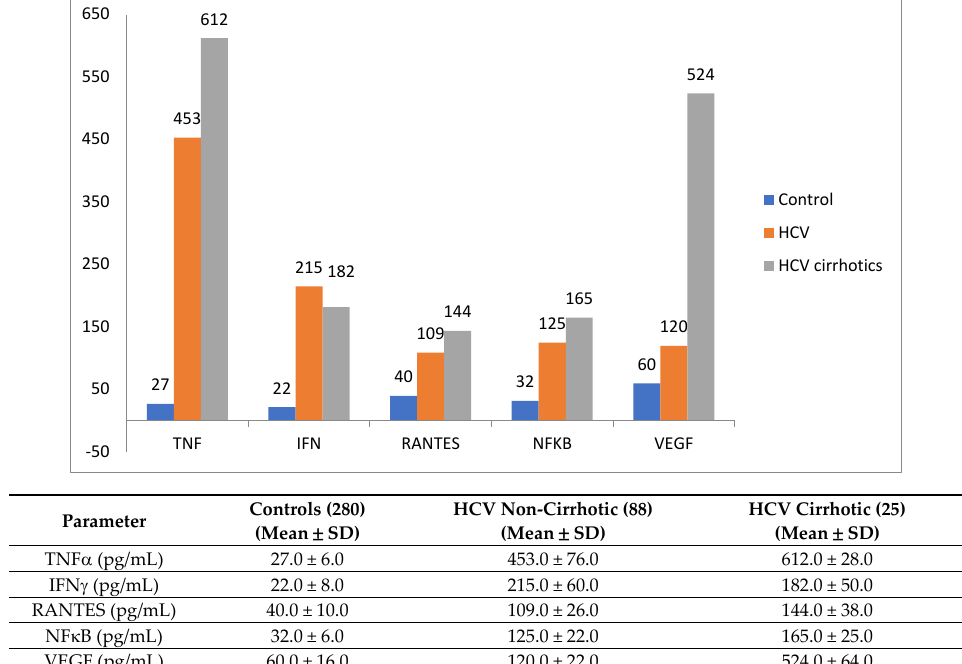
Figure 2. Serum levels of tumor necrosis factor alpha (TNF α ), interferon gamma (IFN- γ ), regulated upon activation normal T cell expressed and secreted (RANTES) nuclear factor kappa B (NF κ B), vas- cular endothelial growth factor (VEGF) in controls, and in HCV-infected patients. All the parameters are expressed as pg/mL; mL-milliliter; pg-picogram. The levels of TNF α are significantly different between the HCV non-cirrhotic and cirrhotic individuals ( p = 0.05) and VEGF ( p = 0.0010). The TEM micrographs present several apoptotic hepatocytes and apoptotic bodies (AB). The micrographs show large deposits of lipids in the cell. The micrograph reveals an enlarged smooth endoplasmic reticulum (ER) and numerous mitochondria. While some mitochondria are normal, others have lost their cristae. An HCV antigen can be ob- served. In addition, the relative number of stellate cells per 100 hepatocytes was more than ten times higher than in the controls. The number of lipid vesicles stored in these stellate cells was 20 times higher than in the controls. Stellate cells in a normal liver only carry between one and four lipid vesicles. Figures 3 and 4 present two different micrographs from a biopsy.